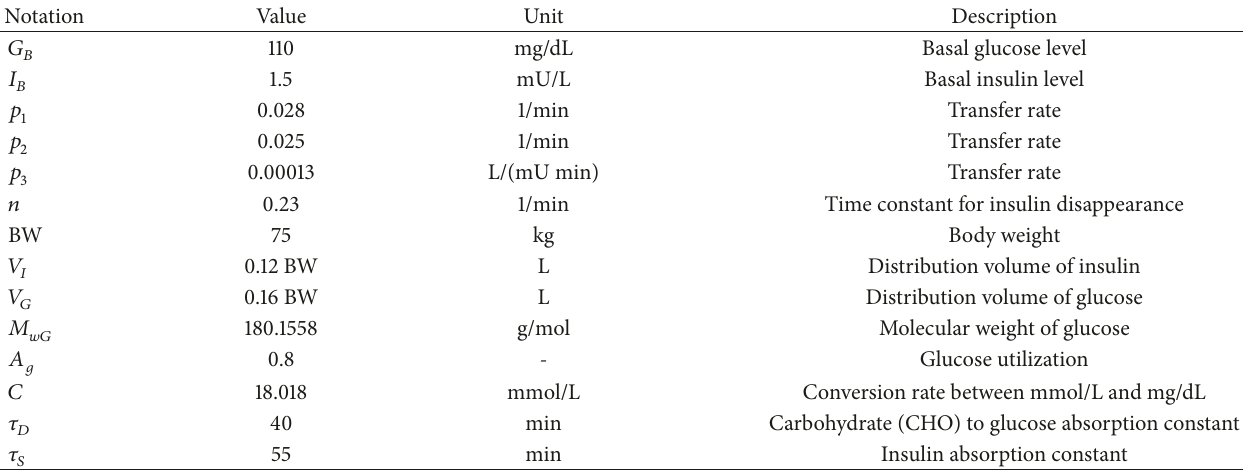
Table 1: The applied parameters of the models in this study